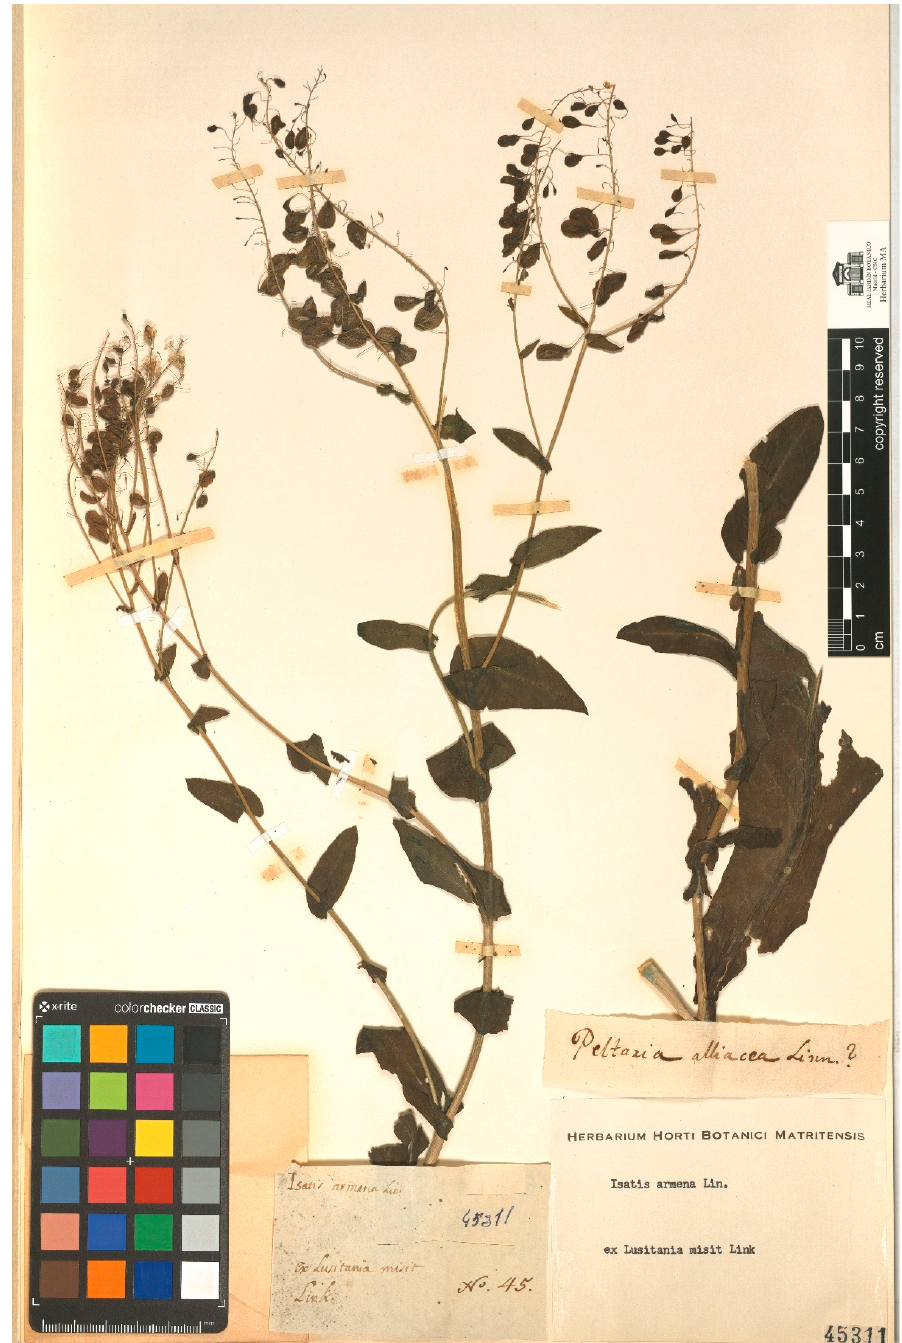
Figure 3. Specimen of Isatis platyloba Hoffmanns. ex Steud., sent by Hoffmannsegg to Cavanilles in April 27, 1801 (MA00045311). 6. Orchis longicruris Link, J. Bot. (Schrader) 2(2): 323 (Apr. 1800) [ O. italica Poir. in Lam., 10. Silene micrantha Link ex Otth in DC., Prodr. 1: 372 (1824). [ ≡ Silene micropetala Encycl. 4: 600 (1798)]. Link [23], when describing the species, indicates that it has “ Labium trifidum, lacinia media trifida, cuius laciniae lateral longissimae, angustissimae, intermedia brevior ”, as corresponds to O. italica and indicates as locality “ Häufig auf